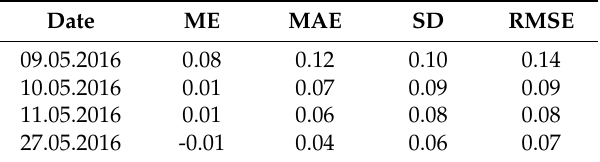
Figure 9. HS (m) obtained from both UAS-DSM and TLS-DSM for four different analysis days. Table 5. Statistical comparison of UAS- and TLS-based HS values.